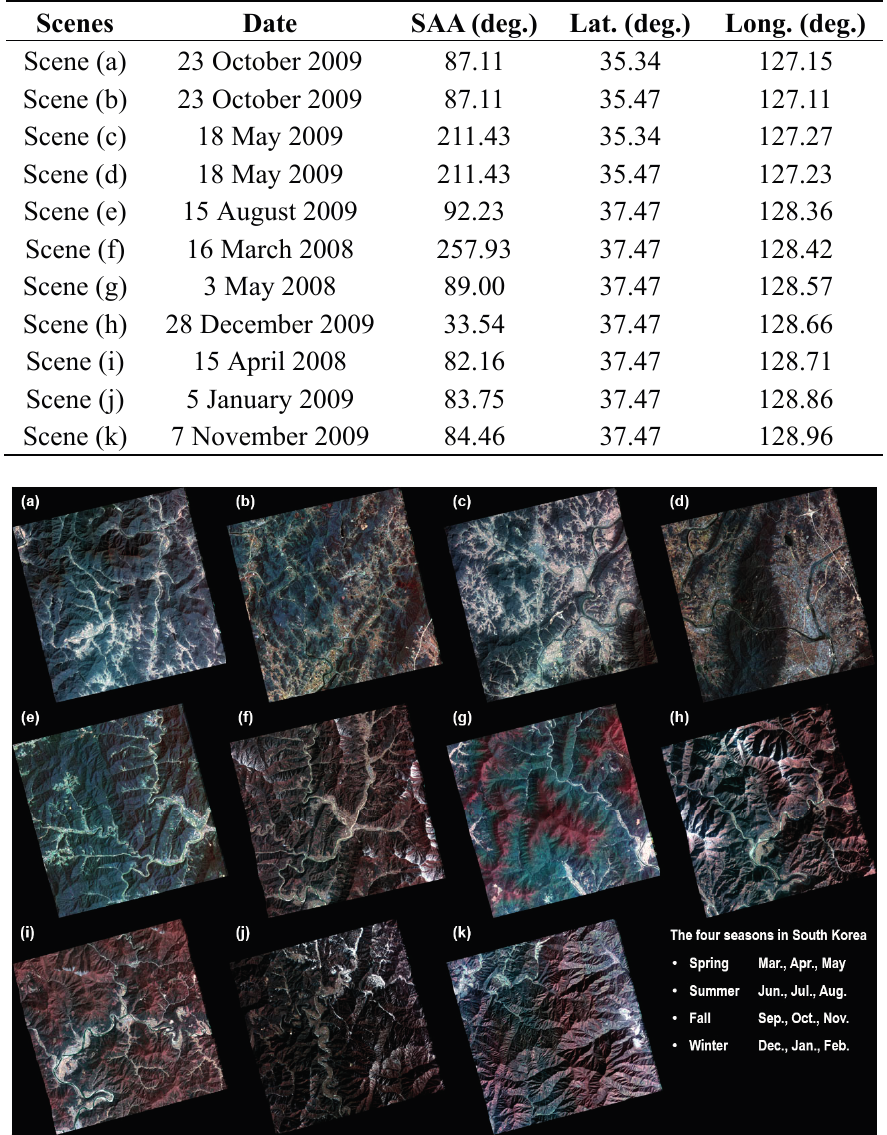
Figure 1. The tested Kompsat-2 images, including the seasonal and topographical characteristics. ( a ) 23 October 2009; ( b ) 23 October 2009; ( c ) 18 May 2009; ( d ) 18 May 2009; ( e ) 15 August 2009; ( f ) 16 March 2008; ( g ) 3 May 2008; ( h ) 28 December 2009; ( i ) 15 April 2008; ( j ) 5 January 2009; ( k ) 7 November